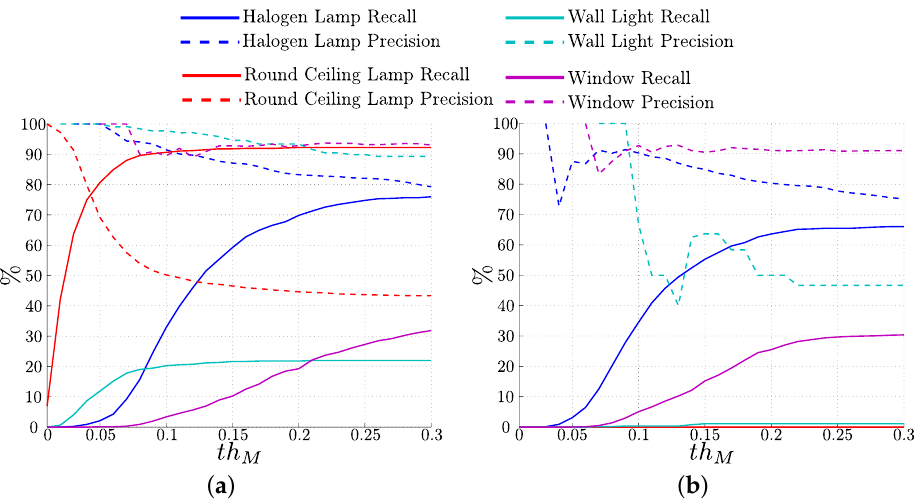
Figure 9. Precision ( dashed line ) and Recall ( solid line ) for the detection of real objects as the matching